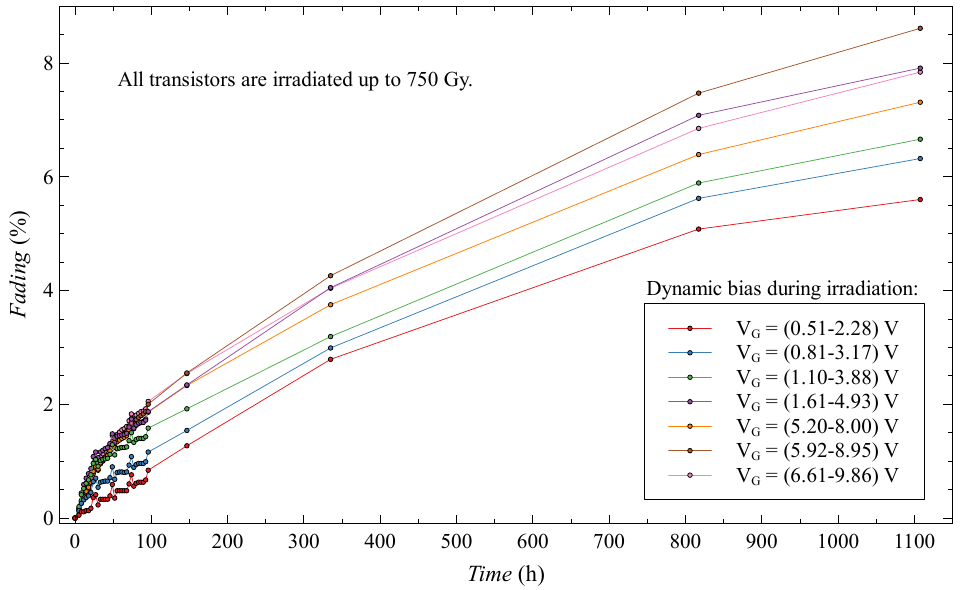
Figure 22. Fading of EPADs with dynamic bias during